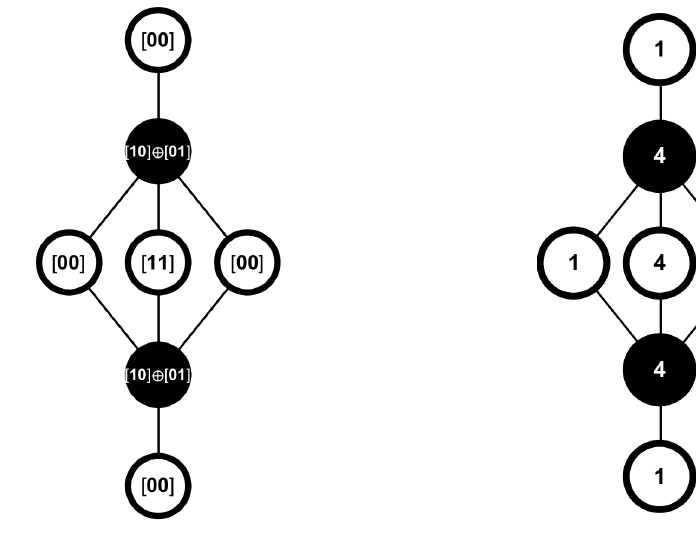
Figure 20 . Adinkra Diagram for 4D minimal scalar